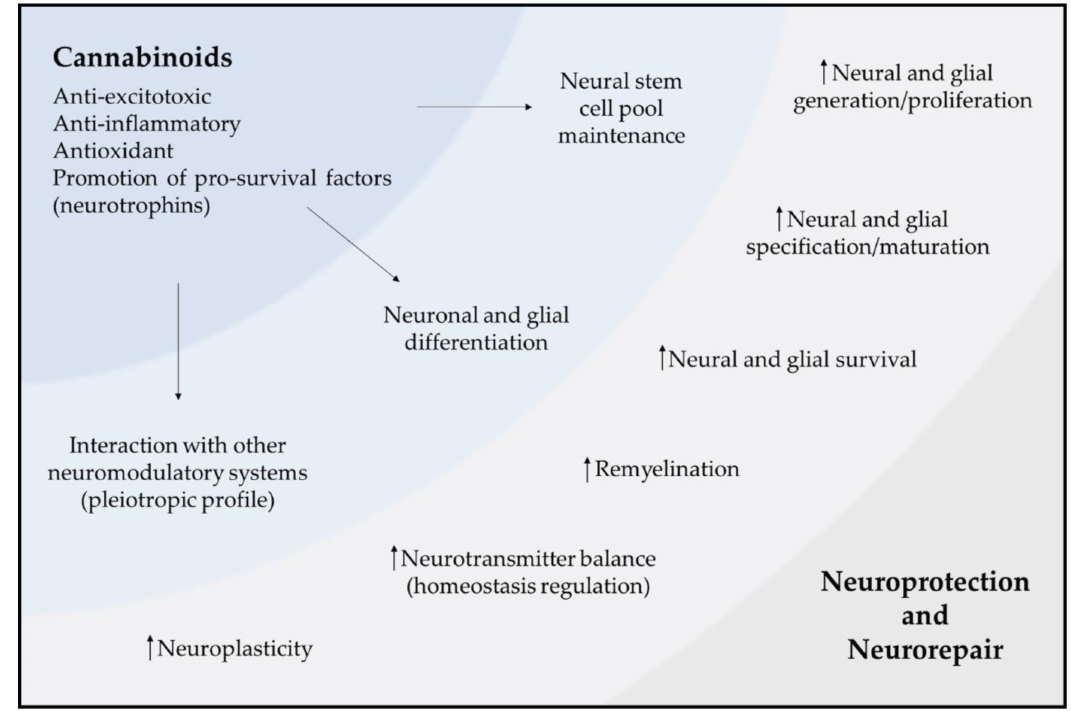
Figure 4. Cannabinoid actions. Cannabinoids exert a pivotal role in controlling neural stem cell dynamics by acting on vital intrinsic/extrinsic signaling pathways, therefore regulating distinct steps of neural stem cells proliferation, differentiation and maturation, namely by maintaining the pool of neural stem cells, promoting neuronal and glial differentiation or by interacting with other neuromodulatory systems. The anti-excitotoxic, anti-inflammatory and antioxidant effects of cannabinoids modulate neuroplasticity, homeostasis, remyelination, survival, maturation and proliferation of both glial and neuronal cells. When taking in account all of these factors, cannabinoids are shown to be extremely versatile molecules with neuroprotective and repair capabilities within the central nervous